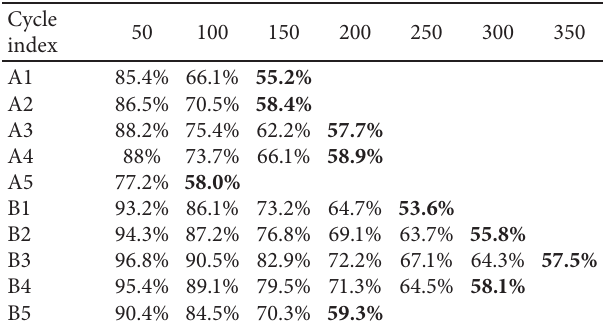
Table 9: Residual dynamic elastic modulus of concrete with dif- ferent freeze-thaw